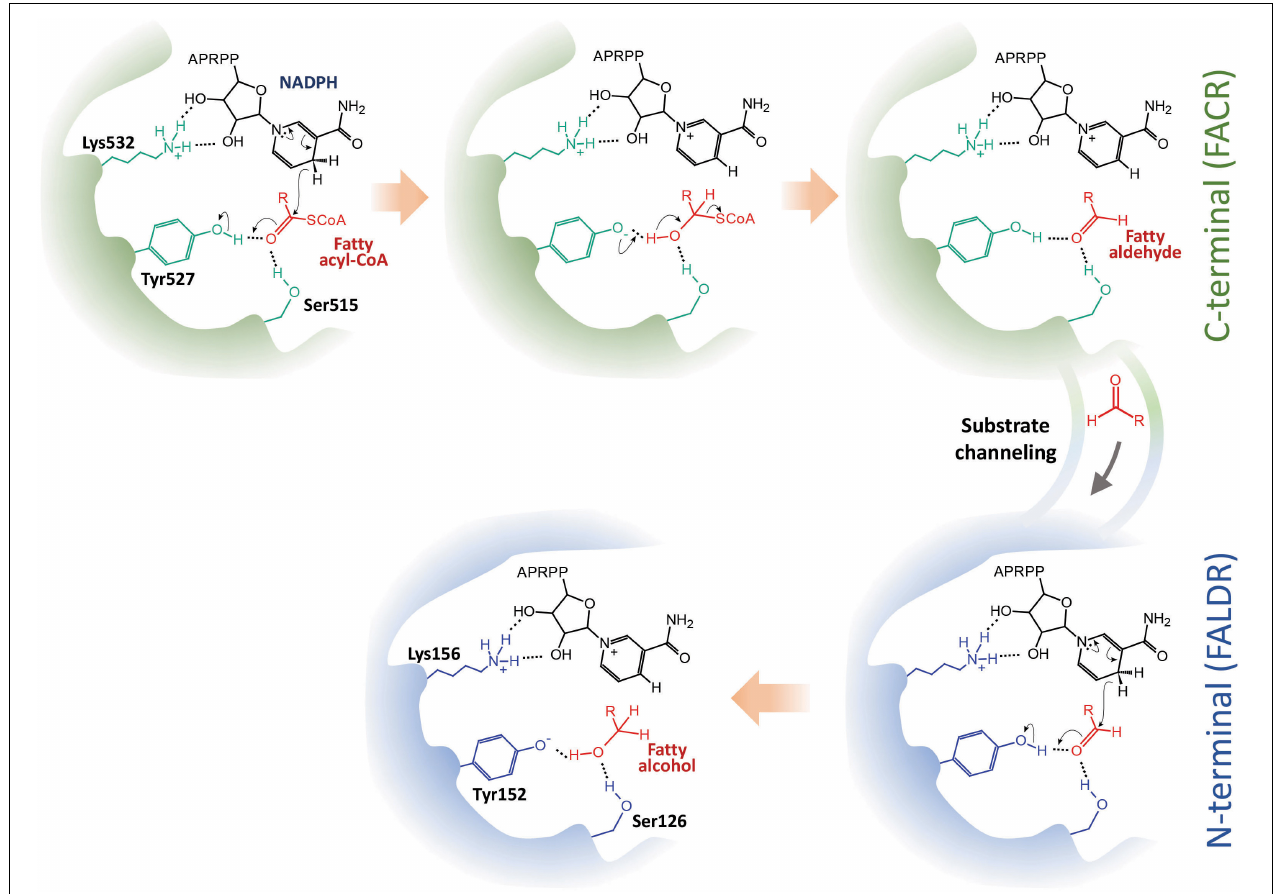
FIGURE 7 | Proposed reaction mechanism of maFACR. We propose a mechanism whereby fatty acyl-CoA is reduced in the C-terminal fatty acyl-CoA reductase (FACR) domain (in green) to aldehyde, which is transferred to the N-terminal fatty aldehyde reductase (FALDR) domain (in blue) for further reduction to fatty alcohol. Ser515 and Tyr527 in the FACR domain first activate the carboxyl group of the fatty acyl-CoA by hydrogen bonding. NADPH, which interacts with Lys532 via hydrogen bonding, donates a hydride to reduce the fatty acyl-CoA to a hemithioacetal upon proton donation by Try527. Subsequent elimination of CoASH forms a fatty aldehyde, which is channeled to the N-terminal. Similarly, Ser126 and Tyr152 activate the carbonyl group of the fatty aldehyde to facilitate reduction by a hydride donated by an NADPH bound to Lys156. Upon accepting a proton from Tyr152, a fatty alcohol is formed. APRPP, adenosine-2-phosphate ribose pyrophosphate moiety of